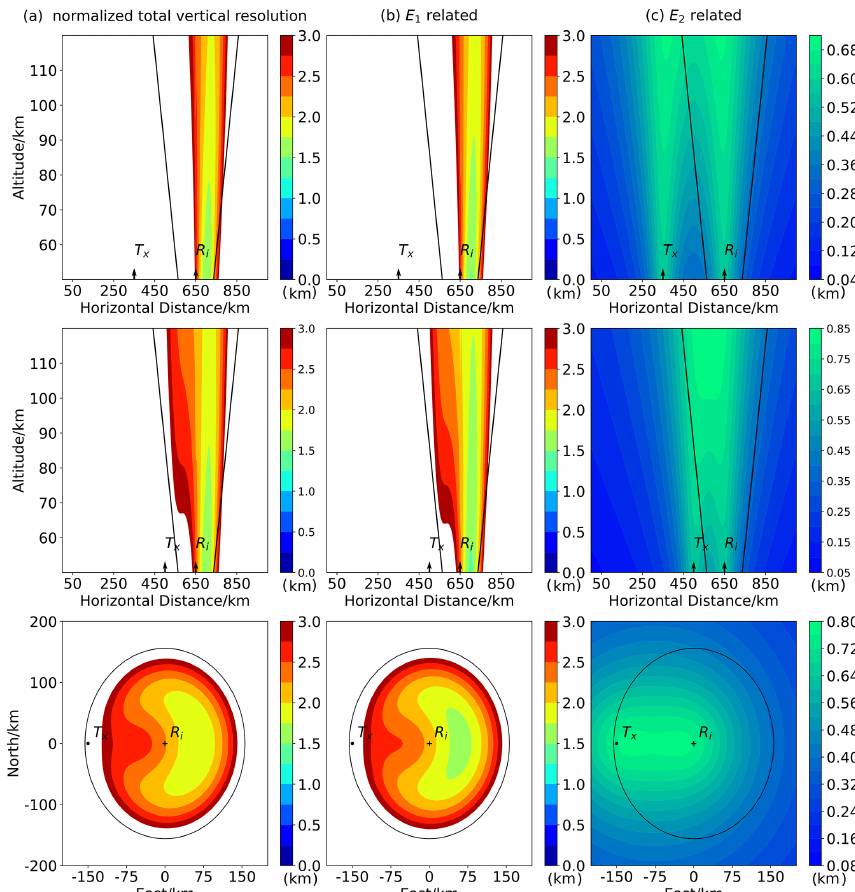
Figure 7. The normalized vertical resolution distribution using the analytical method described in this paper. The first and second rows represent a vertical section of height from 50 to 120km. The third row represents the horizontal section at 90km, and the receiving array is at the origin, with positive coordinate values representing the eastward or northward directions. The first row has the same parameters settings as Fig. 6 and is used to compare with Fig. 6. The E 1 -related resolution will change with the transmitter–receiver configuration because it considers the error term “ δR s ”. Thus, the total vertical resolution will change with the transmitter–receiver configuration. With the transmitter–receiver distance varying from 300km (the first row) to 150km (the second row), the total vertical resolution distribution is clearly changed. The third row is the perspective to the horizontal section at 90km altitude for the second row. Normalized resolution values that exceed 3km are not